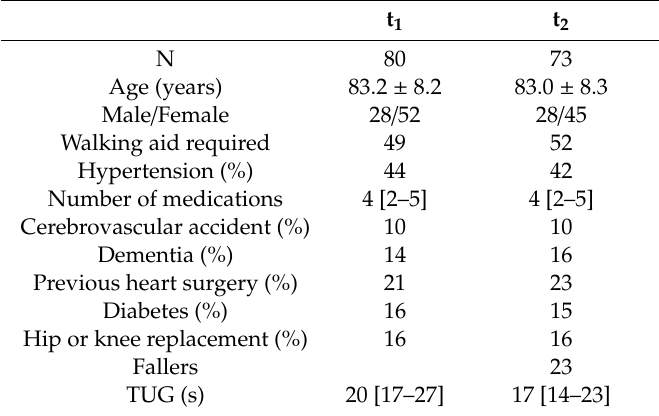
Table 1. Main characteristics, comorbidities and number of medications increasing the risk of fall of the participants. Fallers were identified according to the fall records between the 6 months interval (t 1 and t 2 ). t